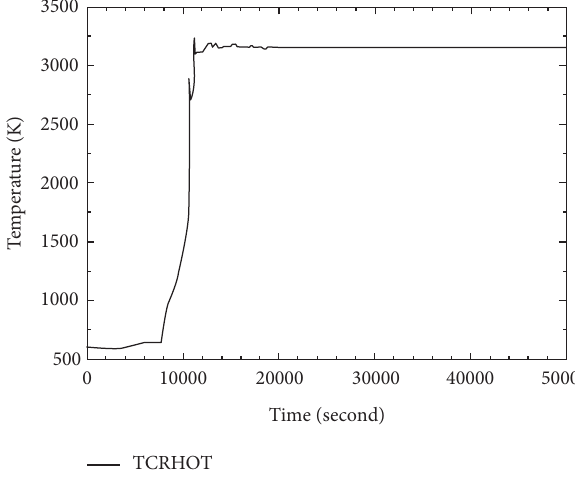
Figure 11: Hottest core node temperature. Table 7: Summary of key events without PAR